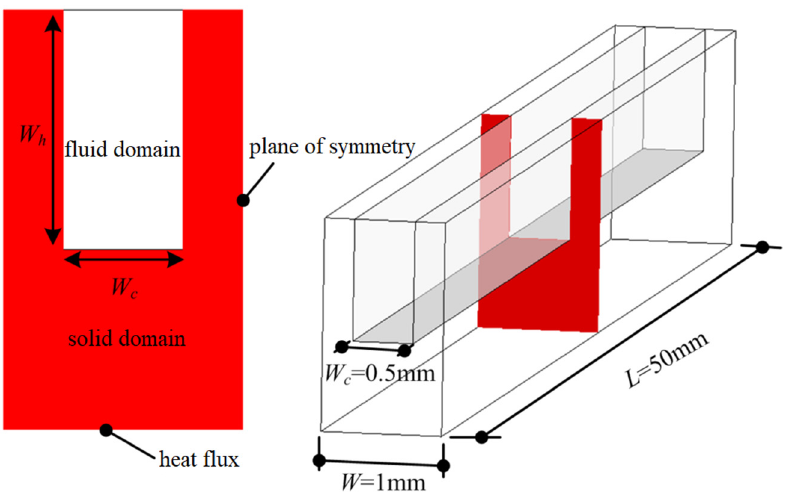
Figure 1. Schematic of heat sink with square cross-section.